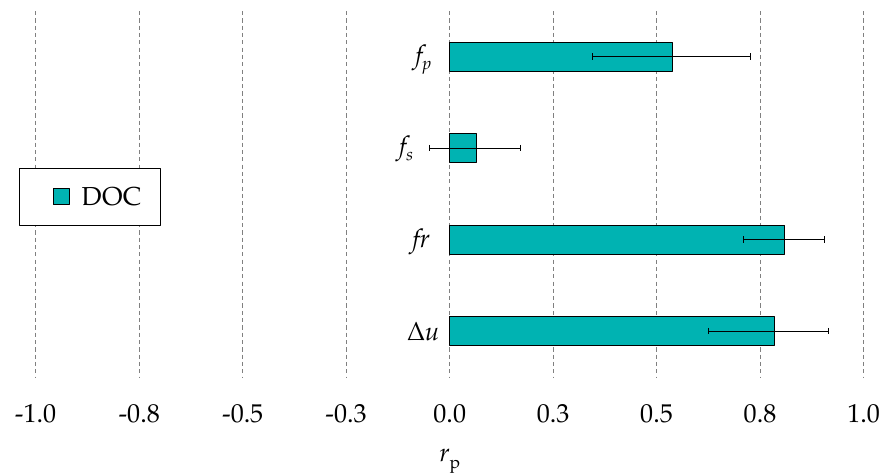
Figure 10. Pearson’s correlation coefficients ( r p ) of the potential indicators for the process fingerprint with respect to the diameter overcut (DOC). Mean values and ranges of the four experimental repetitions are shown.